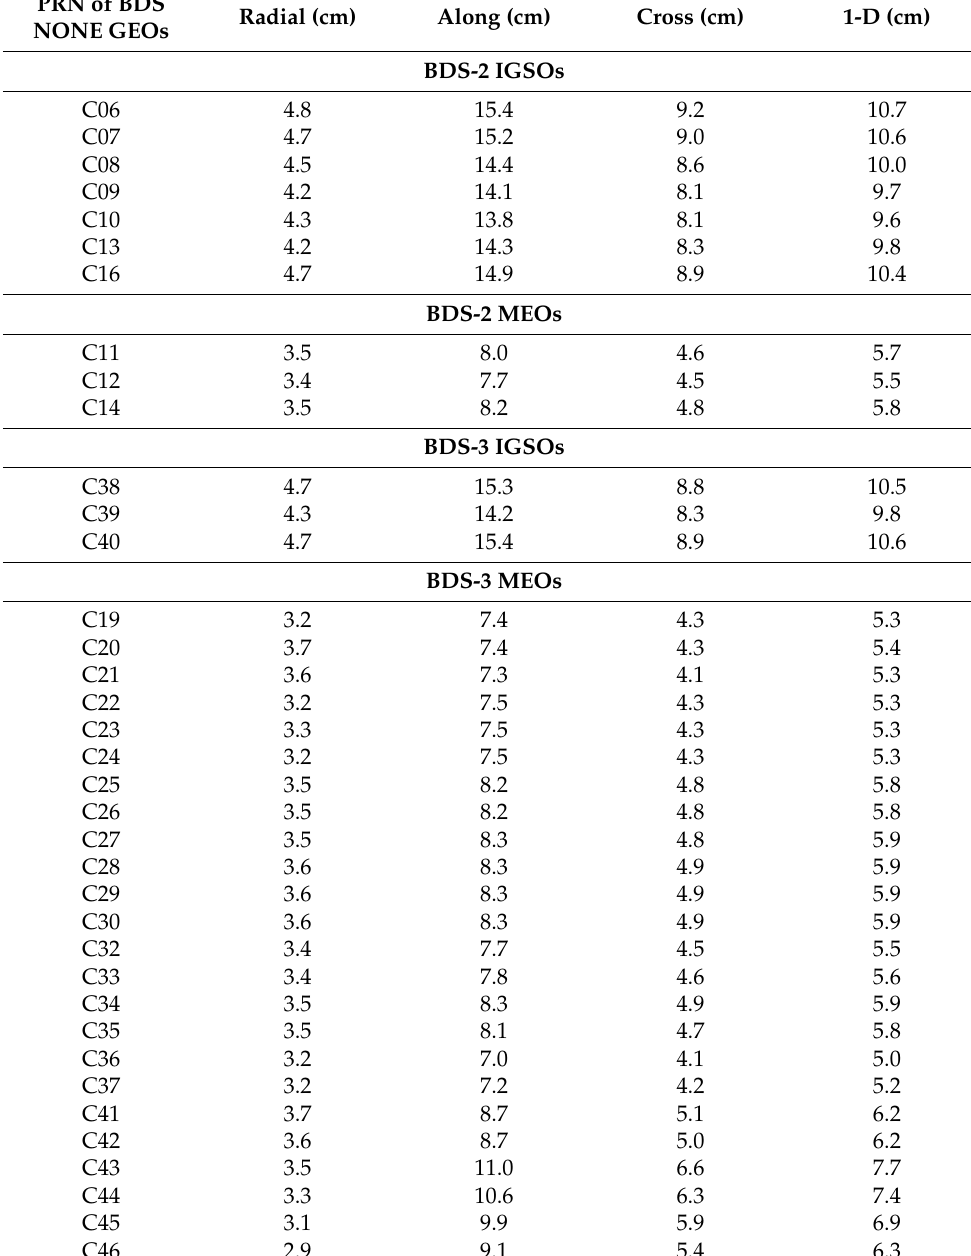
Table 5. Mean RMS value of BDS NONE GEO satellites in comparison with GFZ final orbit.